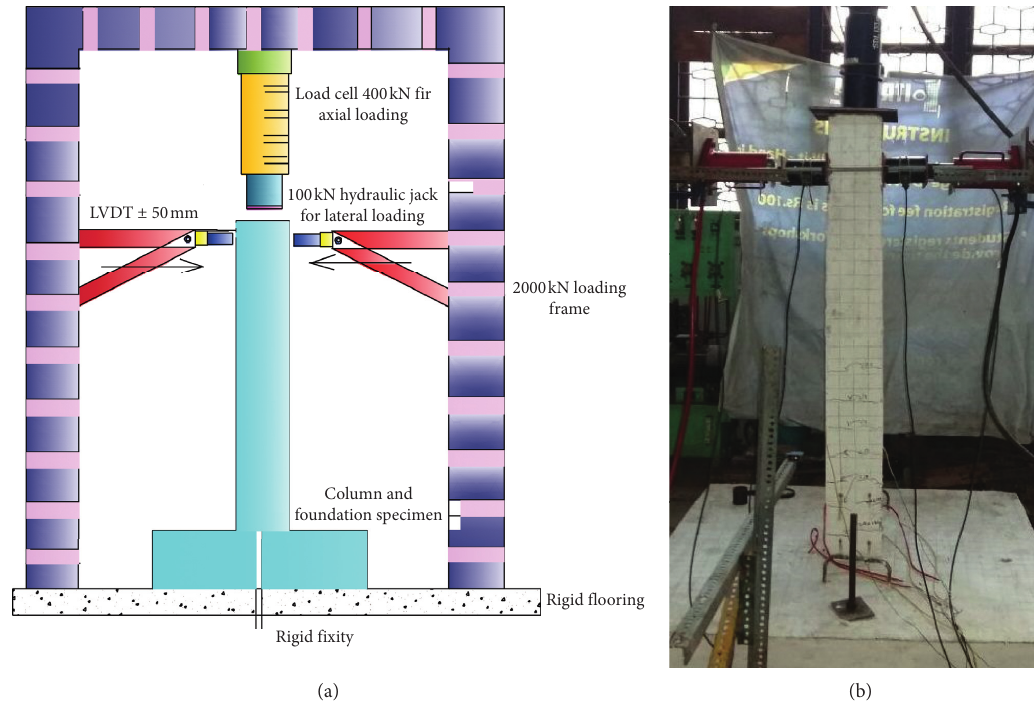
Figure 10: Test set